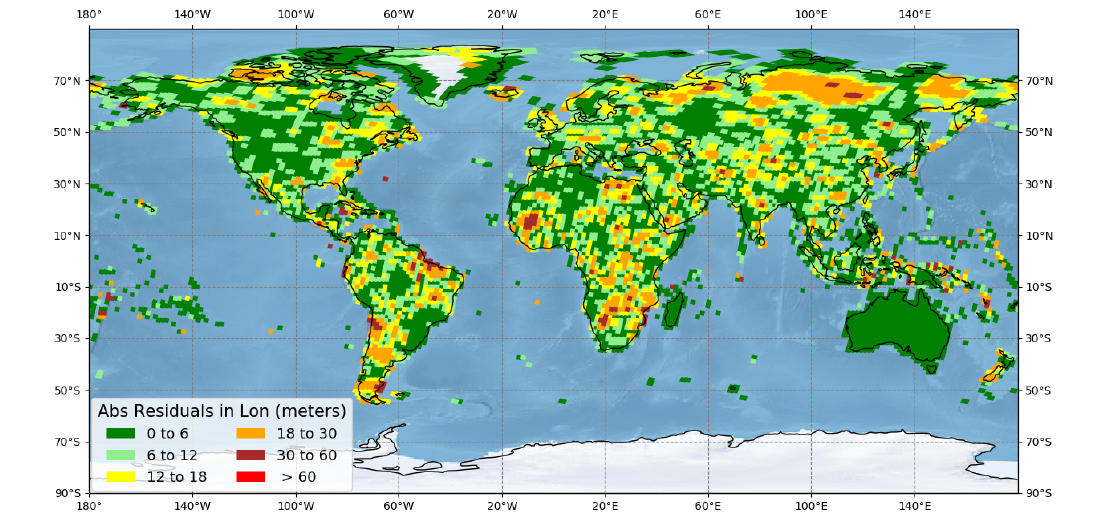
Figure 7. Mean residuals of the GCPs in the longitude direction for each of the WRS-2 paths/rows, computed from the block triangulation